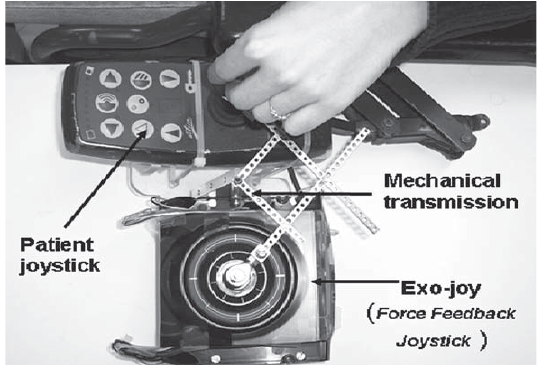
Fig. 7. Exo-joy structure used for the control of electric wheelchair